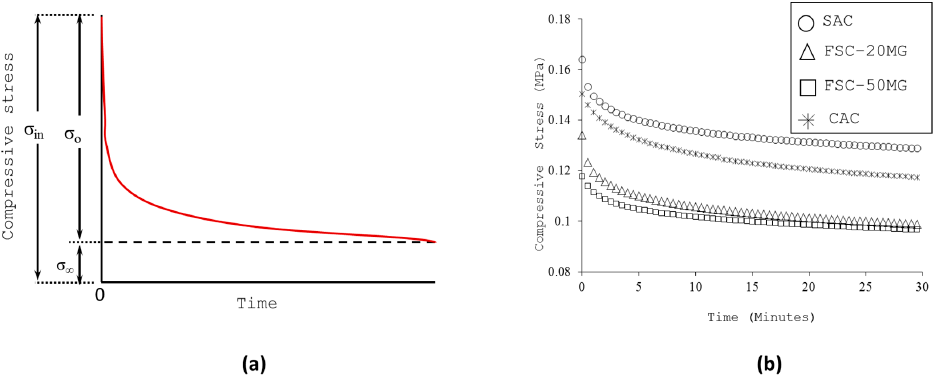
Figure 6. ( a ) Typical stress relaxation curve ( b ) Stress relaxation curve of aerogel composites.